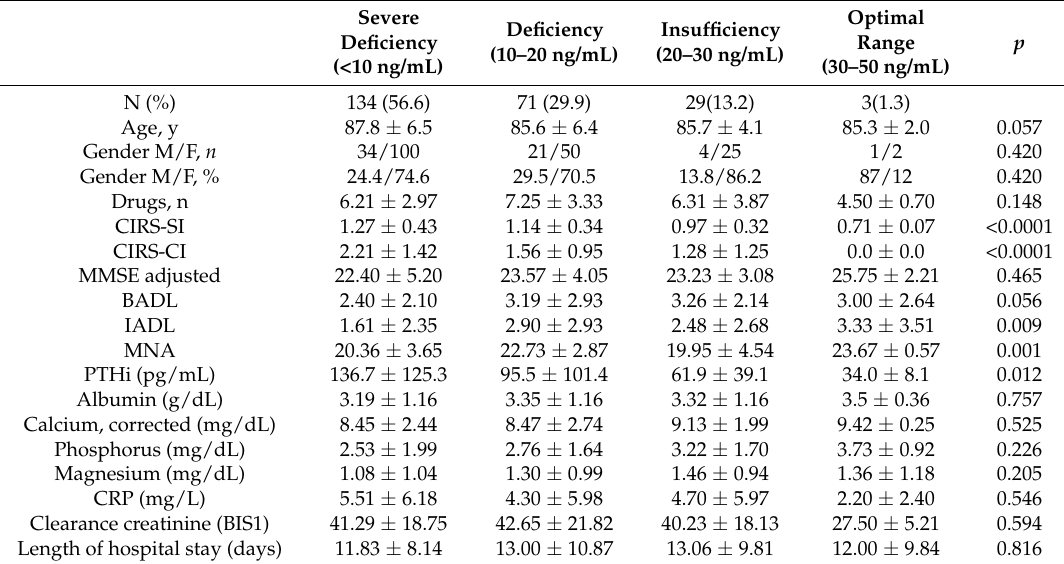
Table 2. Clinical characteristics of patients stratified by vitamin D status.